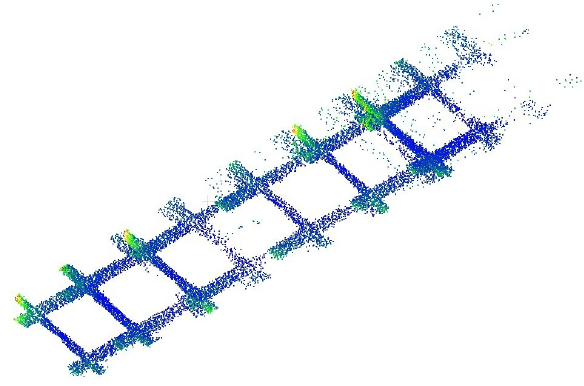
Figure 19. Full grid point cloud reconstructed by successive ICP To assess the feasibility of dimensional measurements in these conditions we calculate the size of the grid marking. Since the contrast between the marking and the asphalt is important, the scalar information of the amplitude image output by the ToF cam- era can be used. The marking is segmented using an arbitrary threshold. Then, rectangles are adjusted in 3D using some se- lected points, see 20. Their sizes can be compared with the phys- ical size of the marking, as shown on Tab. 2 (the theoretical size is 19 × 81 cm).